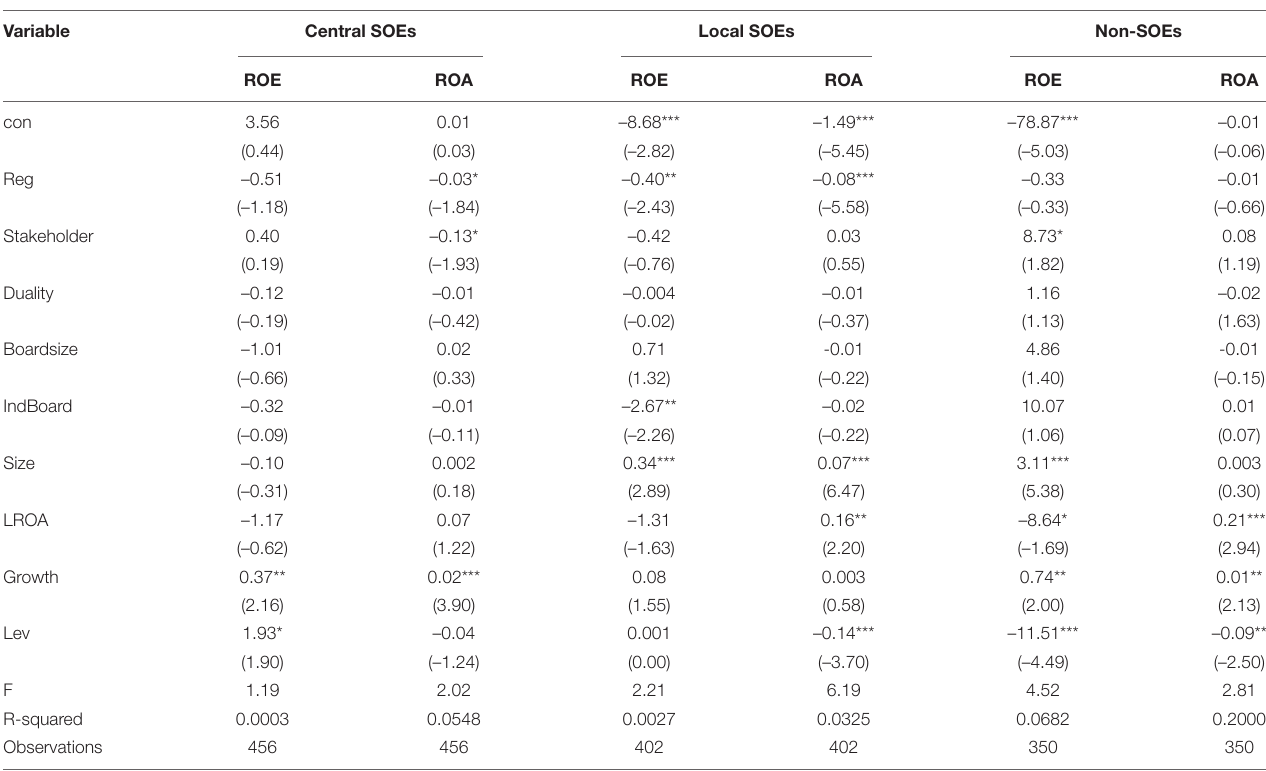
TABLE 7 | Additional test using sub-samples:compensation regulation on